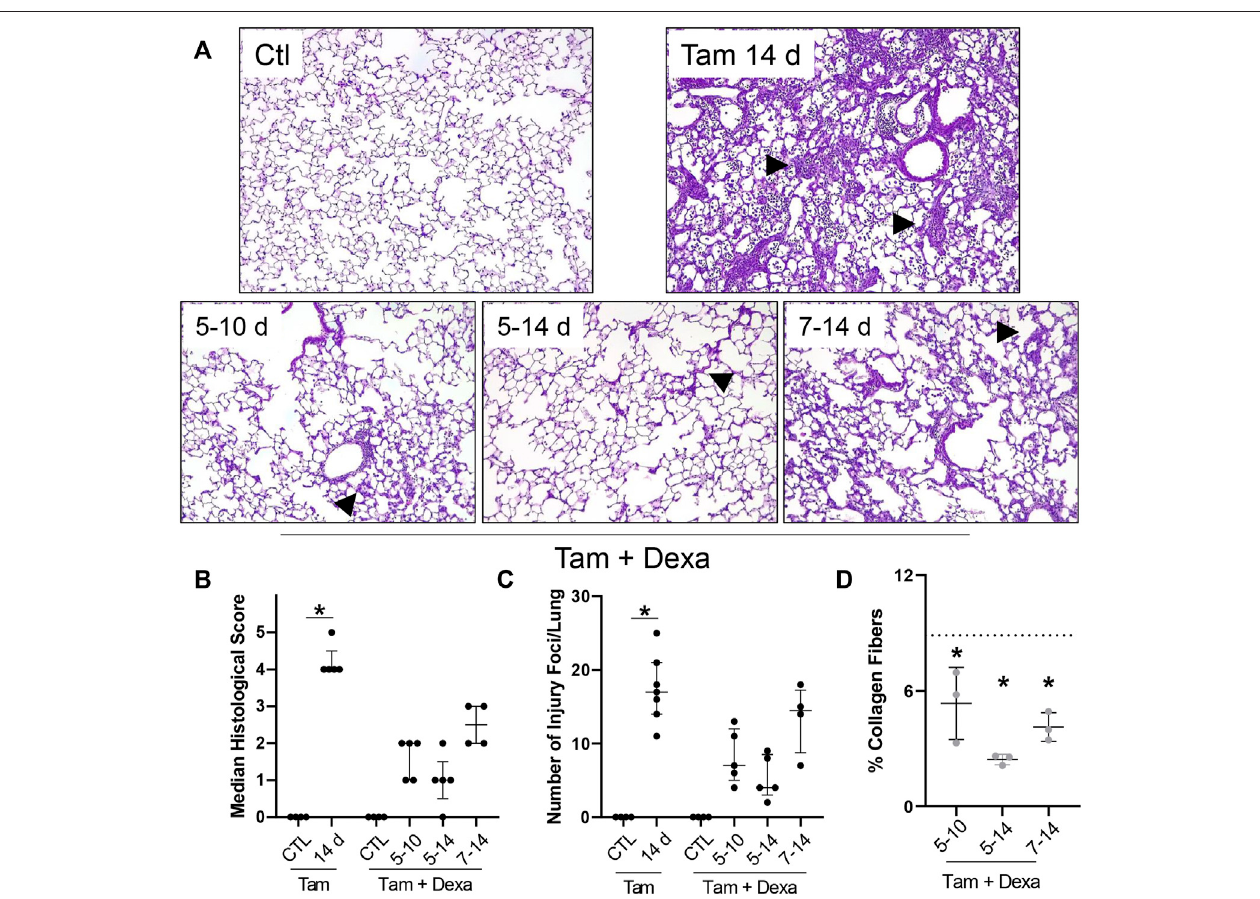
FIGURE 7 | Histopathological effects of dexamethasone administration during SP-C I73T induced injury. (A) Hematoxylin and Eosin stain of tissue sections from control (Ctl, oil treated SP-C I73T mice), tamoxifen treated, or tamoxifen + dexamethasone treated SP-C I73T mice 14 days after injury. Three dexamethasone groups are described (1 mg/kg), receiving daily i.p. injections between day 5 – 10, 5 – 14, or 7 – 14 following tamoxifen induction. Arrowheads represent regions of interest, including septal remodeling edema, cell in fi ltrate. Original magni fi cation: ×100. Representative images from at least 3 mice/group are shown. (B,C) Histological scoring and quanti fi cation offociofinjury,shown asMedian ±interquartilerange, ofcontrol(Ctl,oil treatedSP-C I73T mice), tamoxifen treated,or tamoxifen +dexamethasone treated (day5 – 10;5 – 14;7 – 14)SP-C I73T mice14 daysafterinjury. (D) Quanti fi cationofcollagen fi bercontentintamoxifen+dexamethasonetreatedSP-C I73T mice14 daysafter injury. Three dexamethasone groups are described (1 mg/kg), receiving daily i.p. injections between day 5 – 10, 5 – 14, or 7 – 14 following tamoxifen induction. Each point representsthemeanof fi ve×100imagestakenfromeach section,converted to8-bitonImageJ,andrelativeamountmeasuredusingconstantthresholdsettoproduce between 1and 2% collagen incontroltissues.Ofnote,all images avoided large airways and blood vessels.Images fortamoxifentreated groups wereselected from foci of injury. Data are presented as mean ± SD ( n = 3 – 4), analyzed using two-way ANOVA. *represents groups signi fi cantly different ( p < 0.05) compared to was collagen level in tamoxifen treated specimens (shown as a dotted